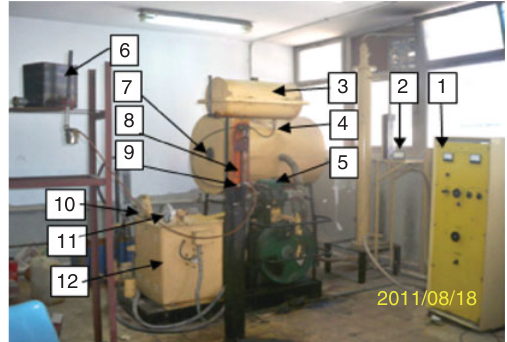
Fig. 4. The schematic diagram of the engine test bed: 1 (cid:2) control panel; 2 (cid:2) temperature indicator 3 (cid:2) base fuel